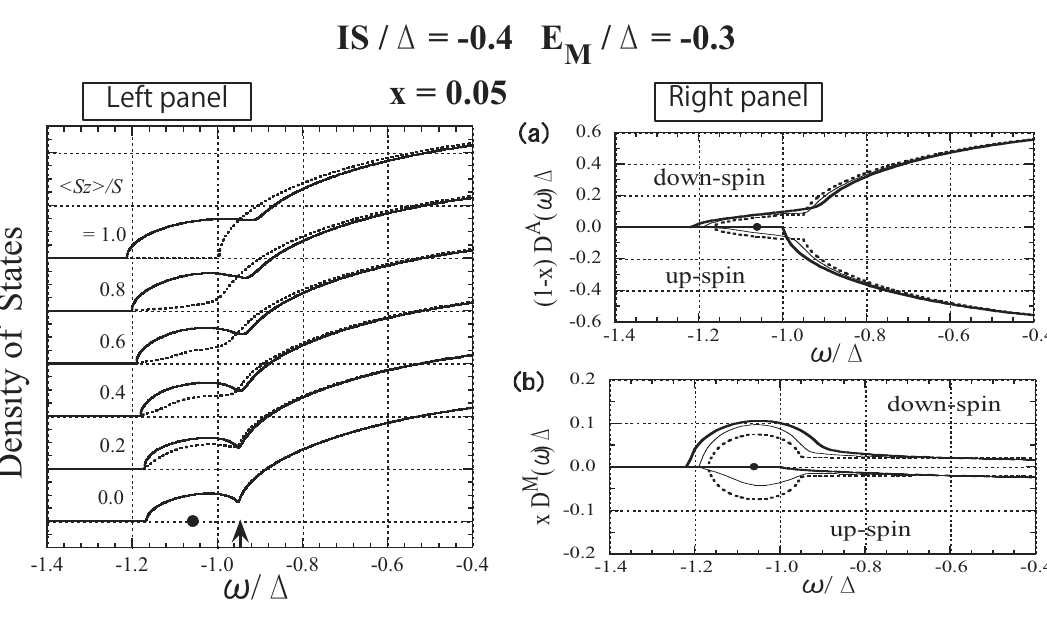
Figure 14. The results for Ga Mn As with x = 0 : 05 . Left panel: Low-energy 1 − x x ⟩ =S . The solid lines represent part of the DOS shown for various values of ⟨ S z the down-spin carrier and the dotted lines represent the up-spin carrier. The arrow indicates the Fermi level for n = x (= 0 : 05) . The impurity level ⟩ = 0 . Right panel: E = − 1 : 057∆ is indicated by a dot on the horizontal line ⟨ S a z ( ! )∆ and − (1 − x ) D A ( ! )∆ and (a) Ga-site component of the DOS, (1 − x ) D A ↑ ↓ ( ! )∆ . The thick, ( ! )∆ and − xD M (b) Mn-site component of the DOS, xD M ↓ ↑ ⟩ =S = 1 : 0 ; 0 : 5 , and 0 : 0 , thin, and dotted lines represent the cases of ⟨ S z respectively. From Takahashi and Kubo [42]. IS / (cid:1063) = -0.4 E / (cid:1063) = -0.3 M x = 0.05 Right